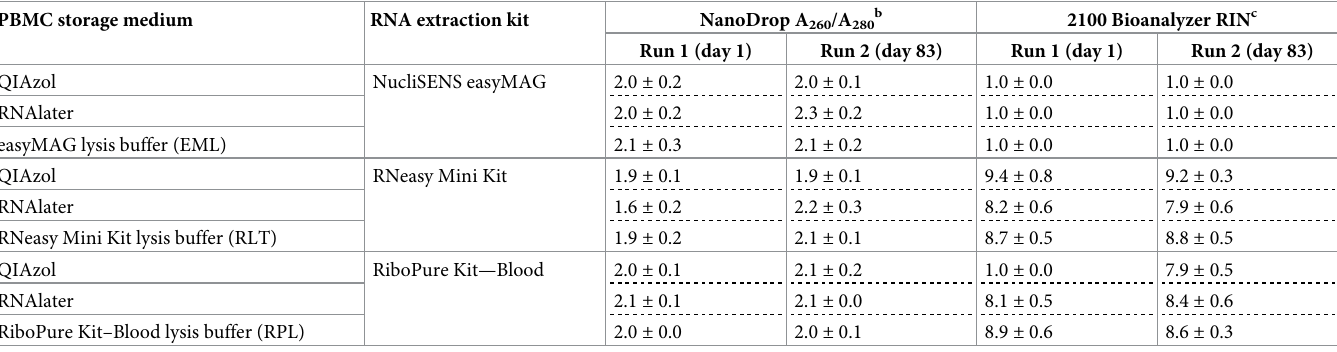
Table 1. RNA purity (NanoDrop) and RNA integrity (2100 Bioanalyzer) for three different RNA extraction kits after storage of PBMCs in three different storage media a . PBMC storage